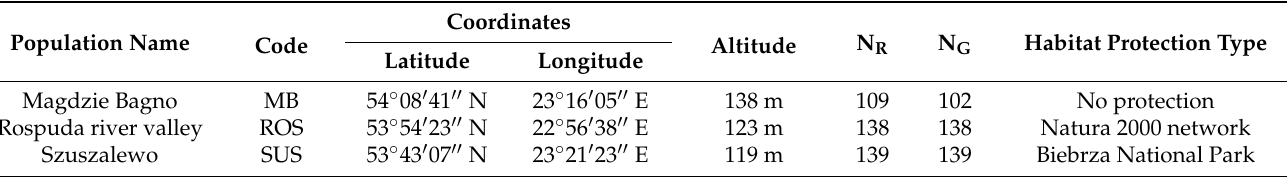
Table 1. Characteristics of the B. humilis populations studied in northeastern Poland. N R —number of ramets sampled, N G —number of genets.